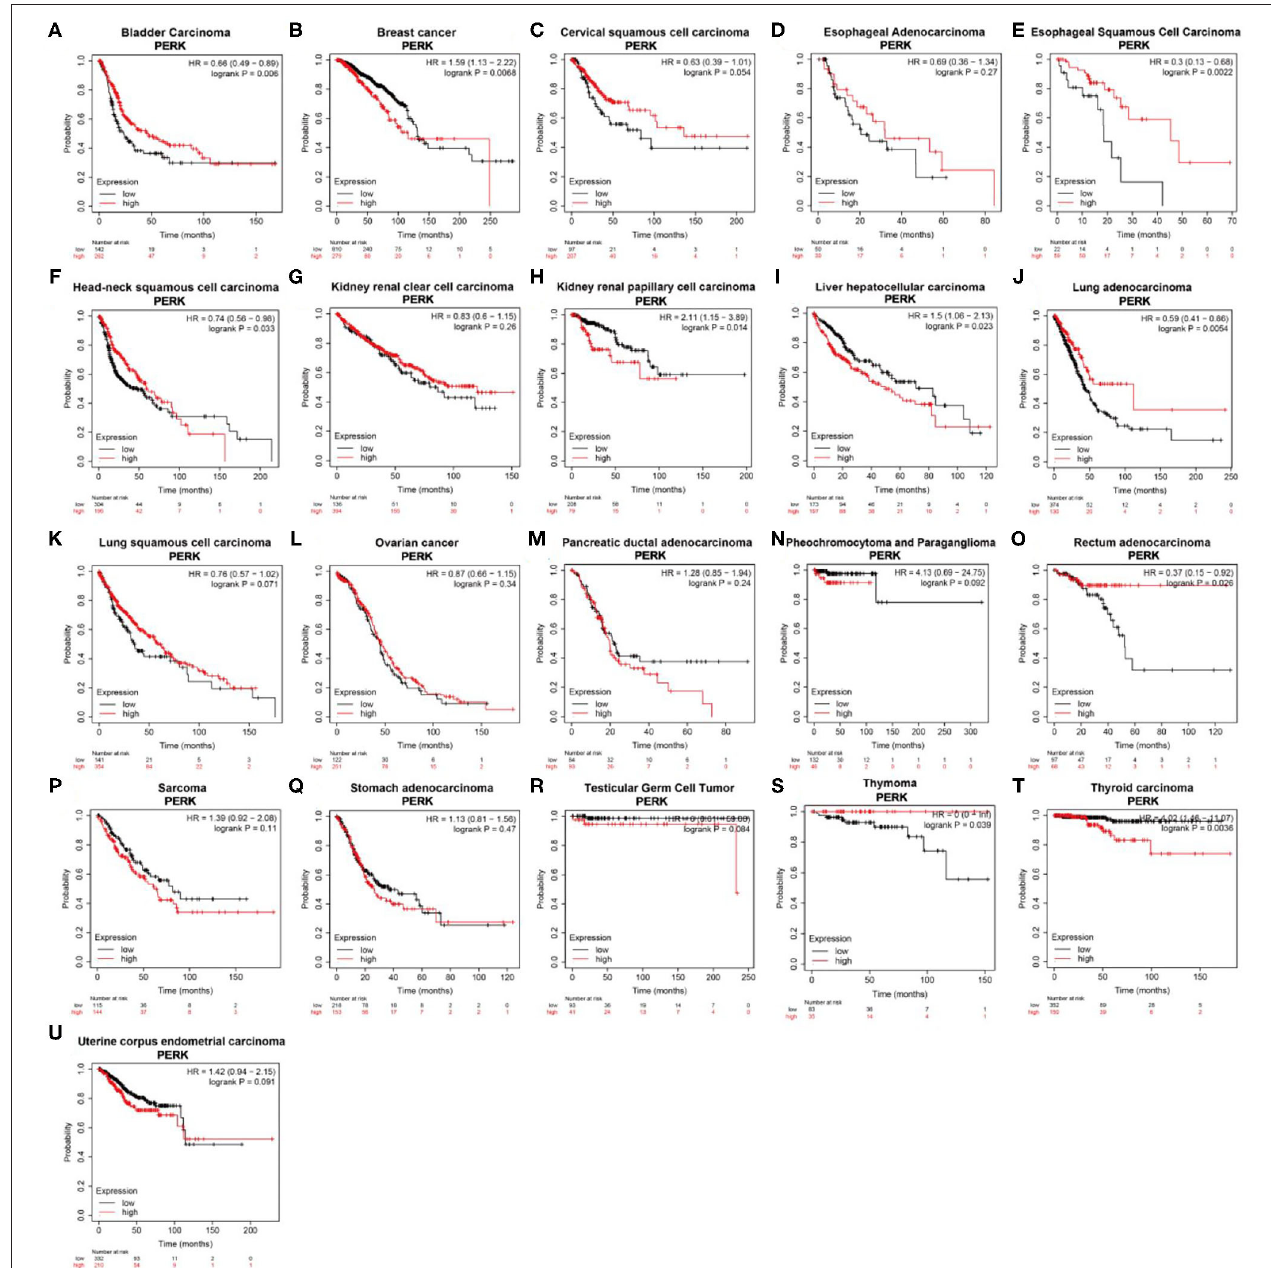
FIGURE 4 | Kaplan–Meier overall survival curves comparing the high and low expressions of PERK in different types of cancer in the Kaplan–Meier plotter.